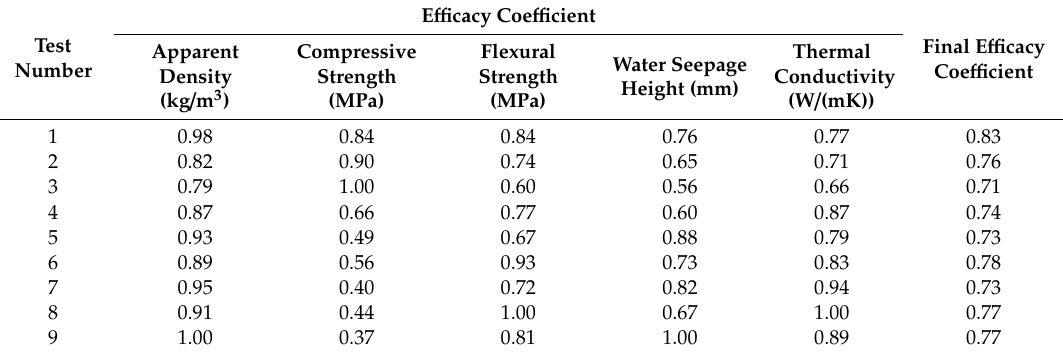
Table 7. Analysis of the e ffi cacy coe ffi cient.